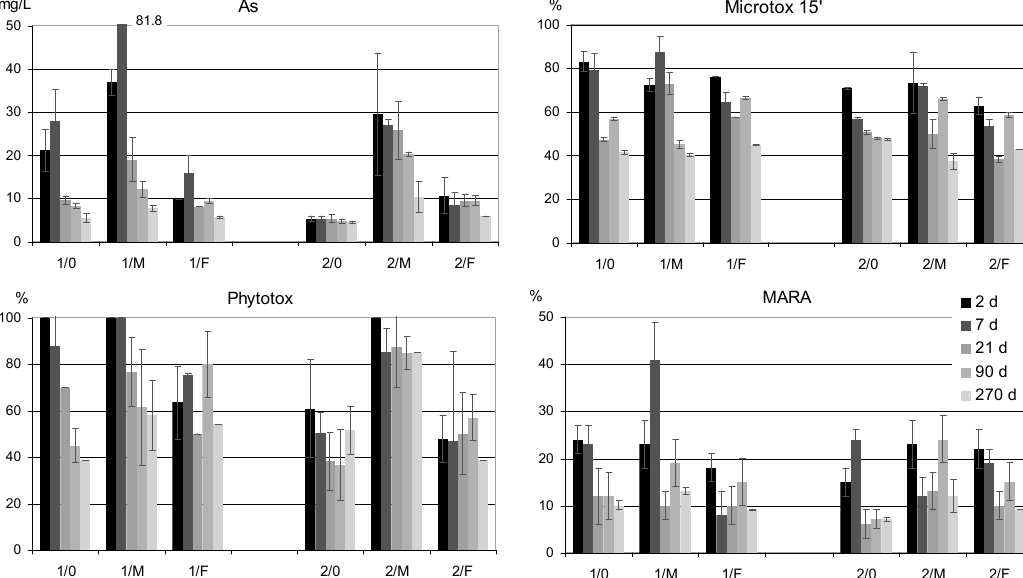
Figure 2. Arsenic concentrations in soil pore water and the results of bioassays, determined after 2, 7, 21, 90, and 270 days of incubation. 1, 2—soil identifiers; 0, M, F—treatments: 0—no addition, M—manure, F—mineral fertilization. The data are mean values of three replicates. Error bars stand for confidence intervals, p = 0.95.